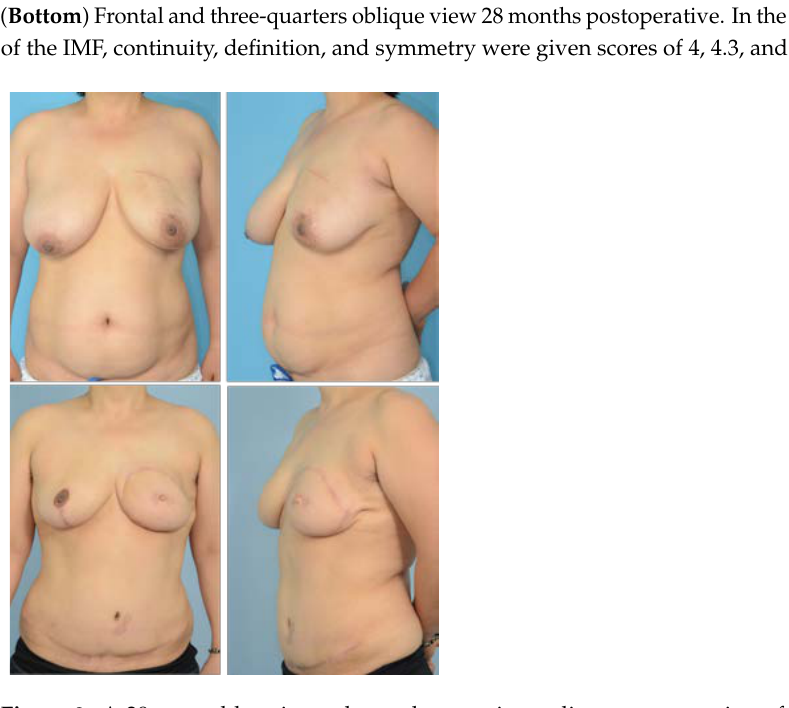
resection and innervated muscle sparing. ( Top ) Preoperative frontal and three-quarters oblique view.